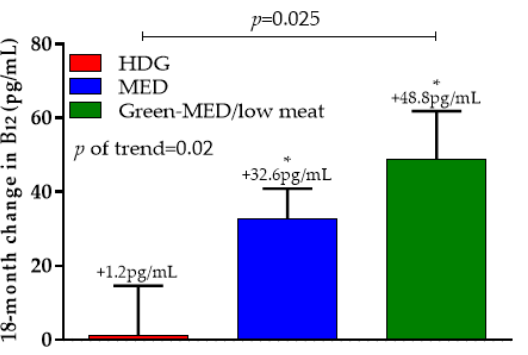
Figure 4. The 18-month change in serum vitamin B 12 across intervention groups. * Indicates within-group change (baseline vs. T18) at the 0.05 level. Data presented as means and SEM. HDG, healthy dietary guidelines; MED, Mediterranean.